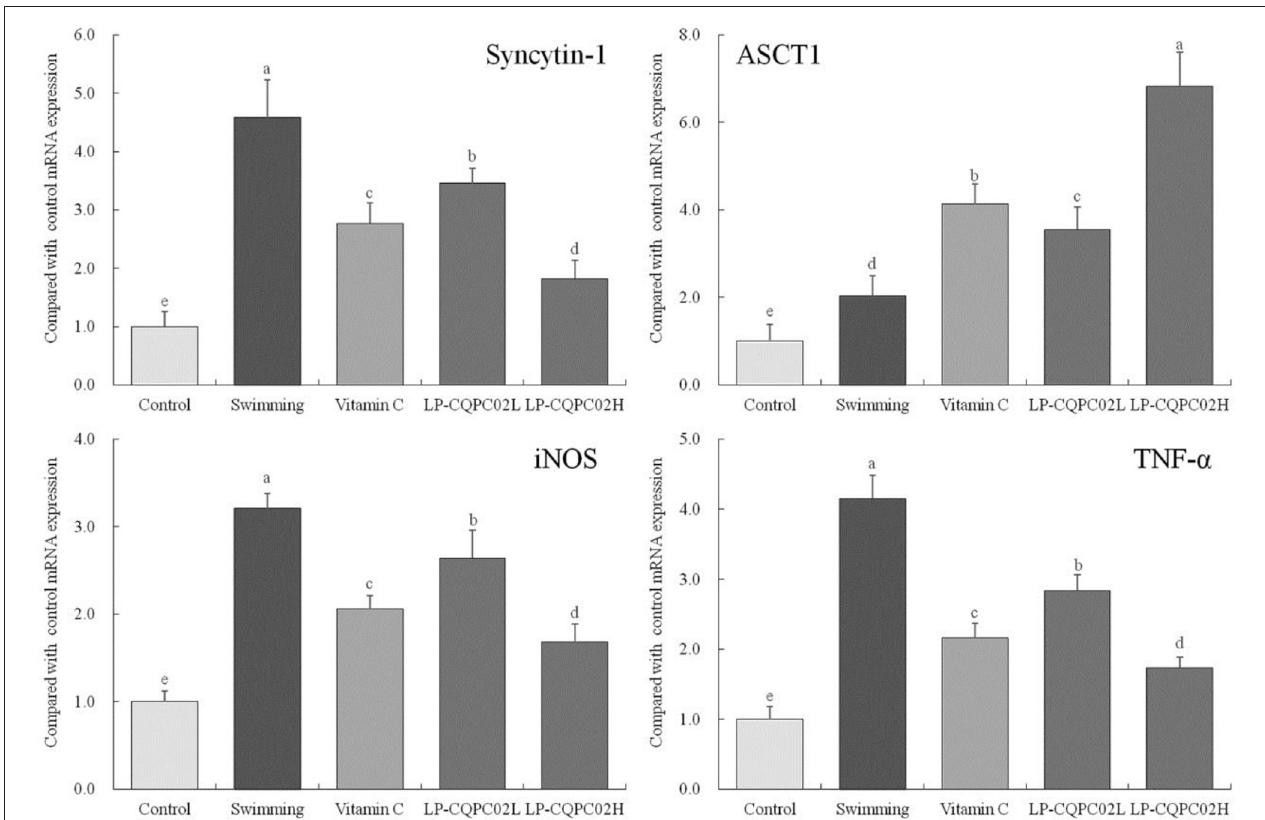
FIGURE 4 | Syncytin-1, ASCT1, iNOS and TNF- α mRNA expression of skeletal muscle c tissue in mouse. a − e After the Tukey’s honestly significantly different test analysis, there is significant difference between the two groups with different superscript ( P <